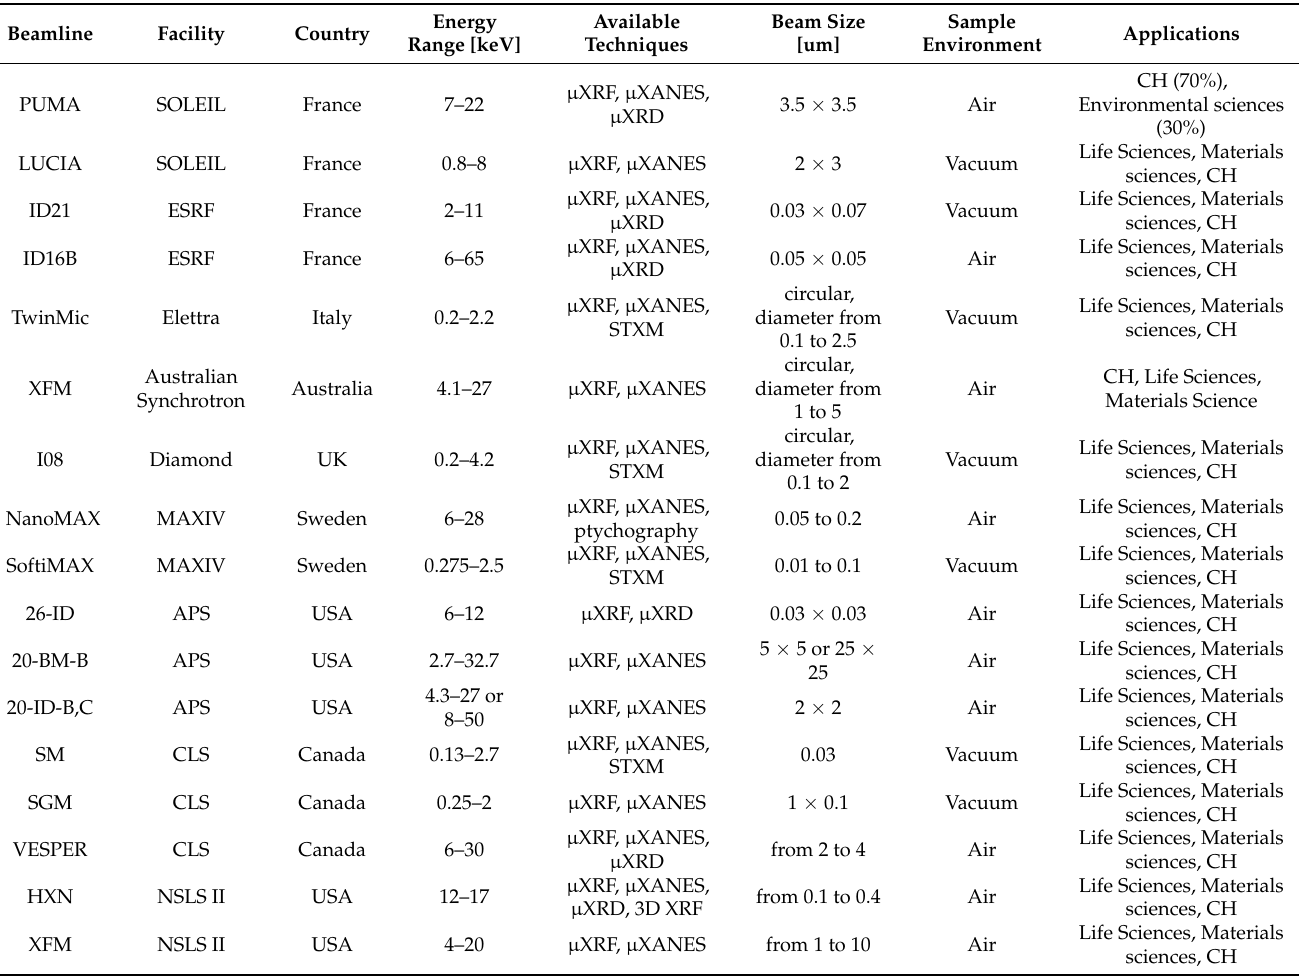
Table 1. List of synchrotron beamlines suitable for materials science applications (especially cultural heritage) with the indication of available techniques and some practical and useful set-up